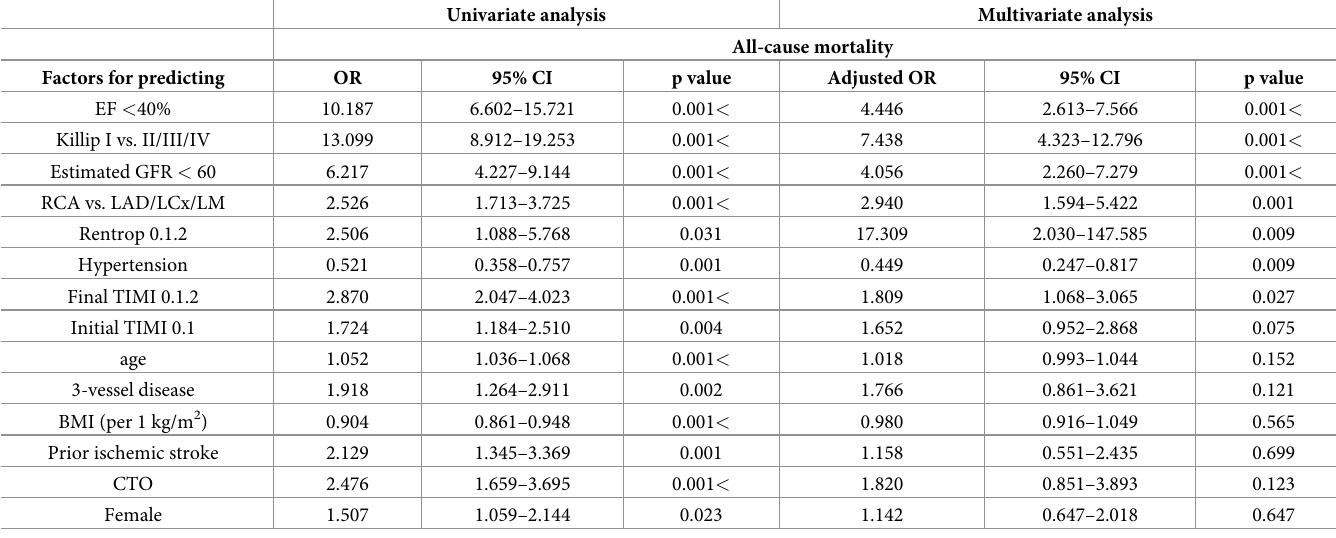
Table 4. Univariate and multivariate regression analysis for the association between in-hospital mortality and clinical findings. Univariate